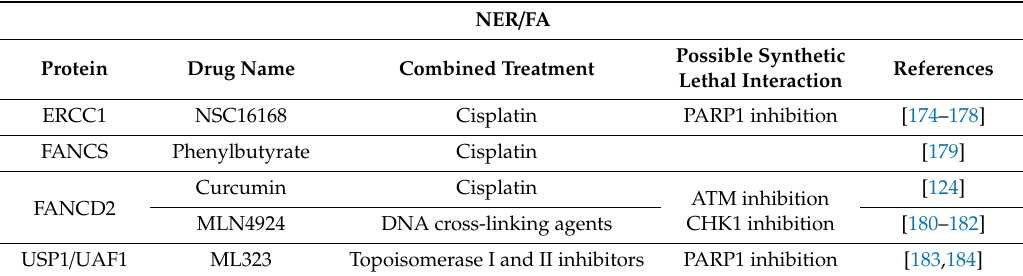
Table 6. NER / FA-related proteins targeted in cancer